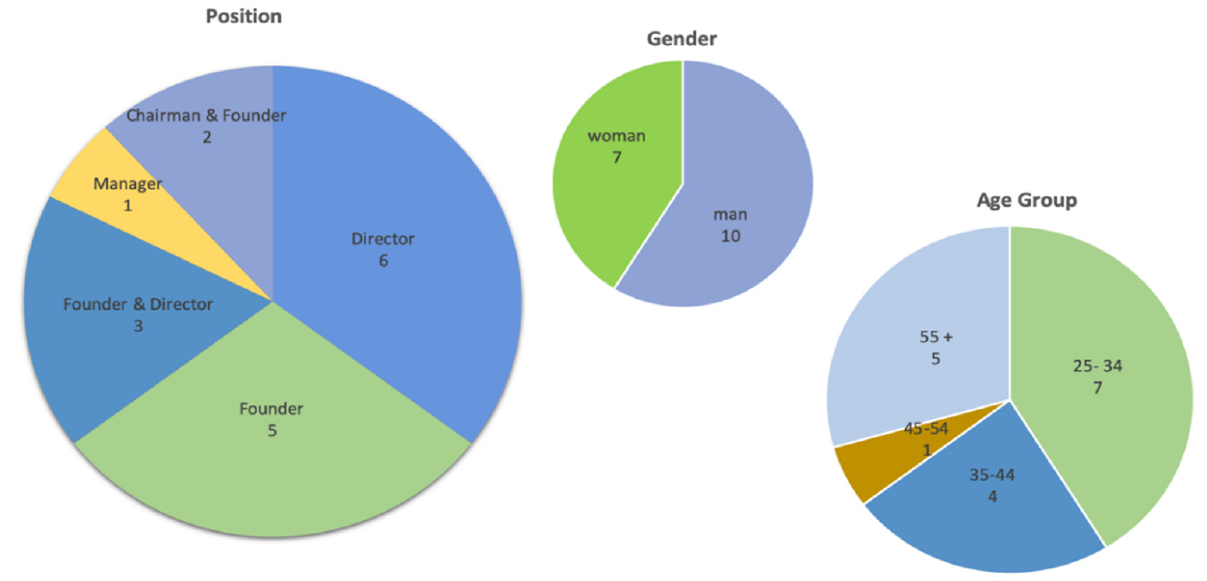
Figure 4. Sample Characteristics. Source: own data.